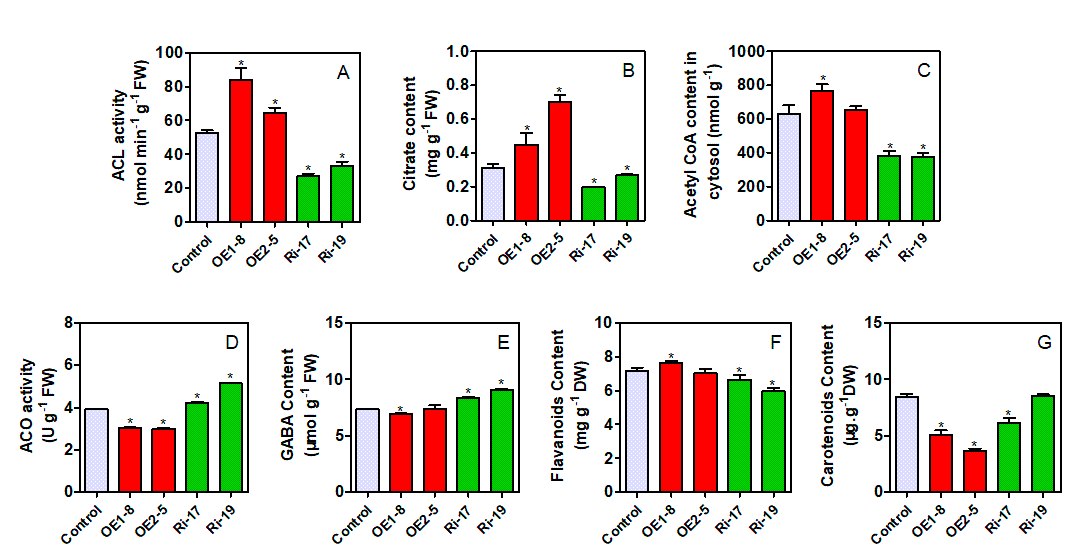
Figure 6. Changes of ACL activity ( A ), citrate concentration ( B ), acetyl-CoA concentration ( C ), cyt-ACO activity ( D ), GABA ( E ), flavonoids ( F ), and carotenoids ( G ) concentrations in citrus callus lines of CitACL α 1 β 1 overexpression (OE) and RNA interference (Ri). Asterisk (*) indicates that the difference is significant between the transgenic line and the control at p < 0.05 ( t -test).